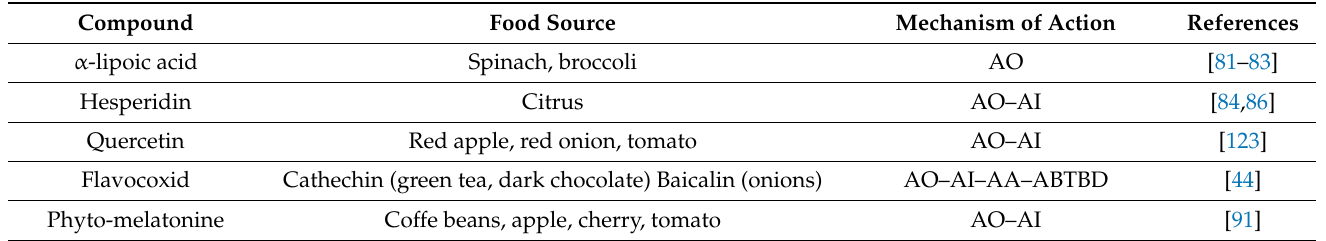
Table 1. Table indicating the role of various nutraceuticals against Cd-induced testicular injury, including compounds, food sources, mechanisms of action and specific